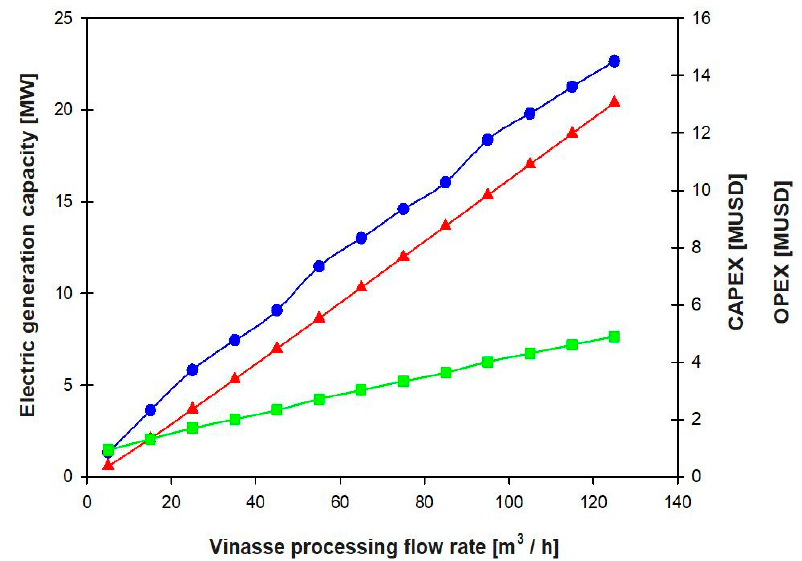
Figure 5. Effect of vinasse processing flow rate on electrical generation capacity (capital expenditure (CAPEX) and operational expenditure (OPEX)). Blue circles: CAPEX; red triangles: electrical generation capacity; and green squares: OPEX.